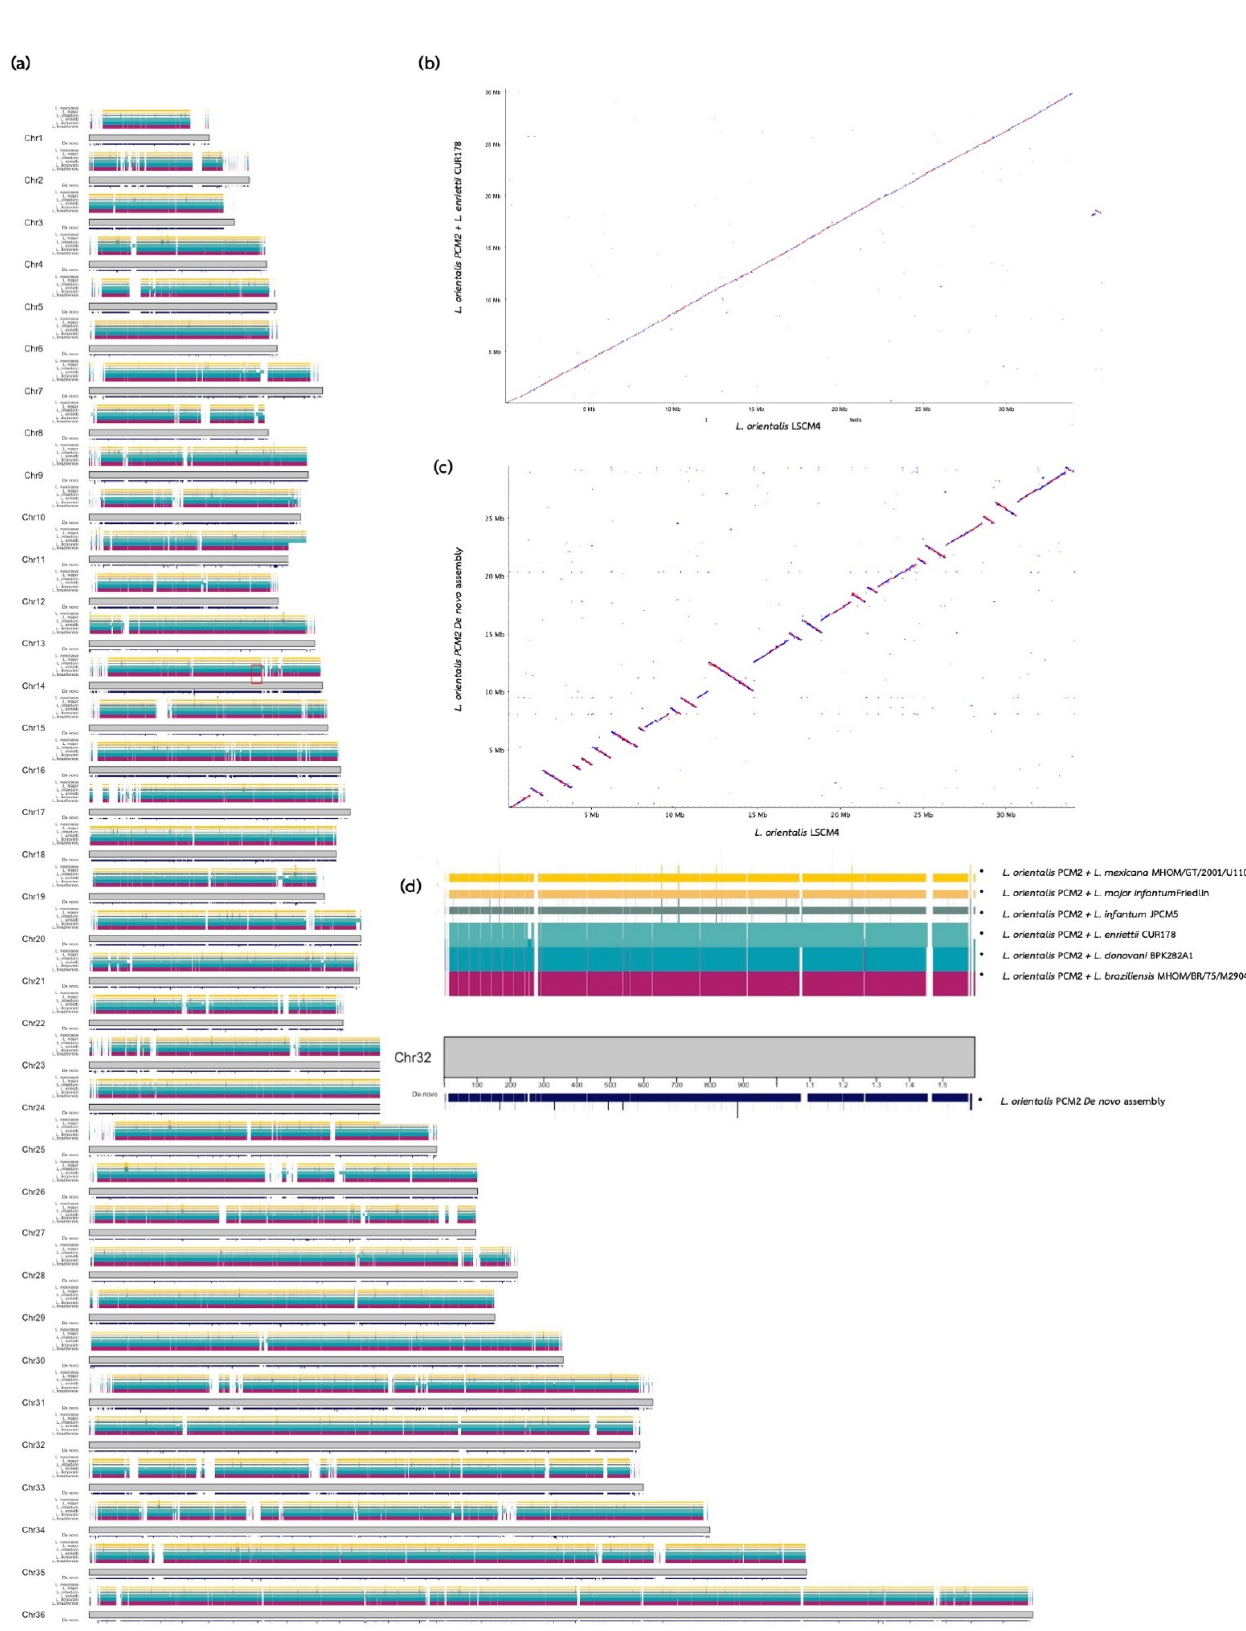
Figure 3. Comparative read mapping of the contigs of L. orientalis isolate PCM2 from different assembly methods: (1) a single de novo step; (2–7) six reference-based assemblies integrated with multi-step de novo assembly, and the salvage of the unmapped reads, with the